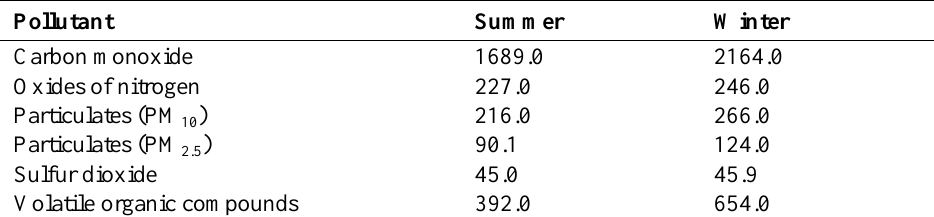
Table 1. Seasonal variation in total daily emissions (tonnes per